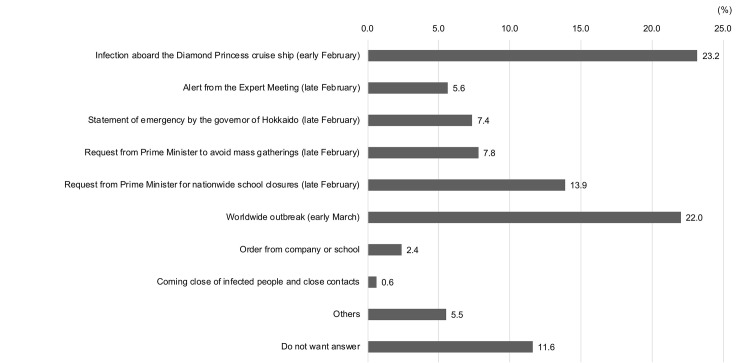
“What was the most important event influencing these actions?”.